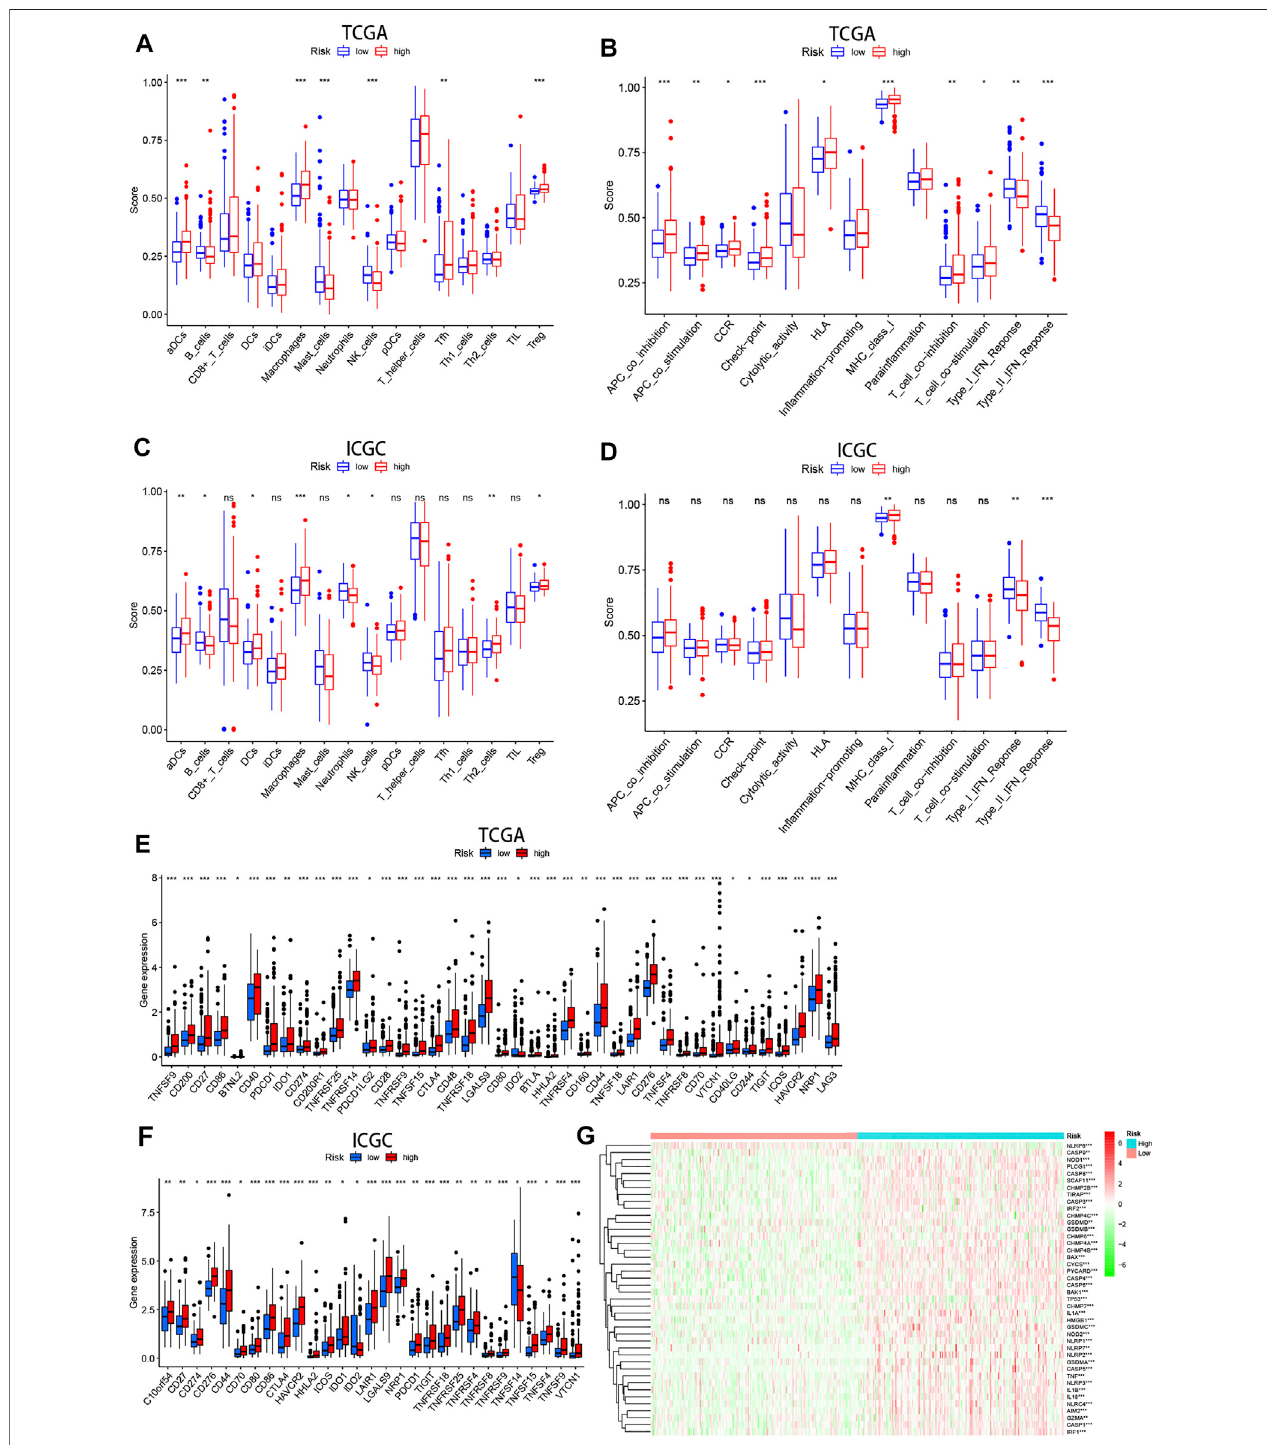
FIGURE 9 | The immune status difference between high- and low-risk HCC patients. (A – D) Comparison of immune cell abundance and immune pathway activation in high- and low-risk groups in the TCGA and ICGC cohort. (E,F) Immune checkpoint expression in high- and low-risk groups in the TCGA and ICGC cohort. (G) Heatmap showing expression of the pyroptosis-related genes in the high- and low-risk groups.